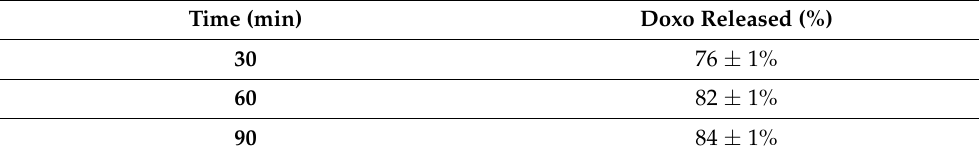
Table 3. The percentage of Doxo released at different time points.